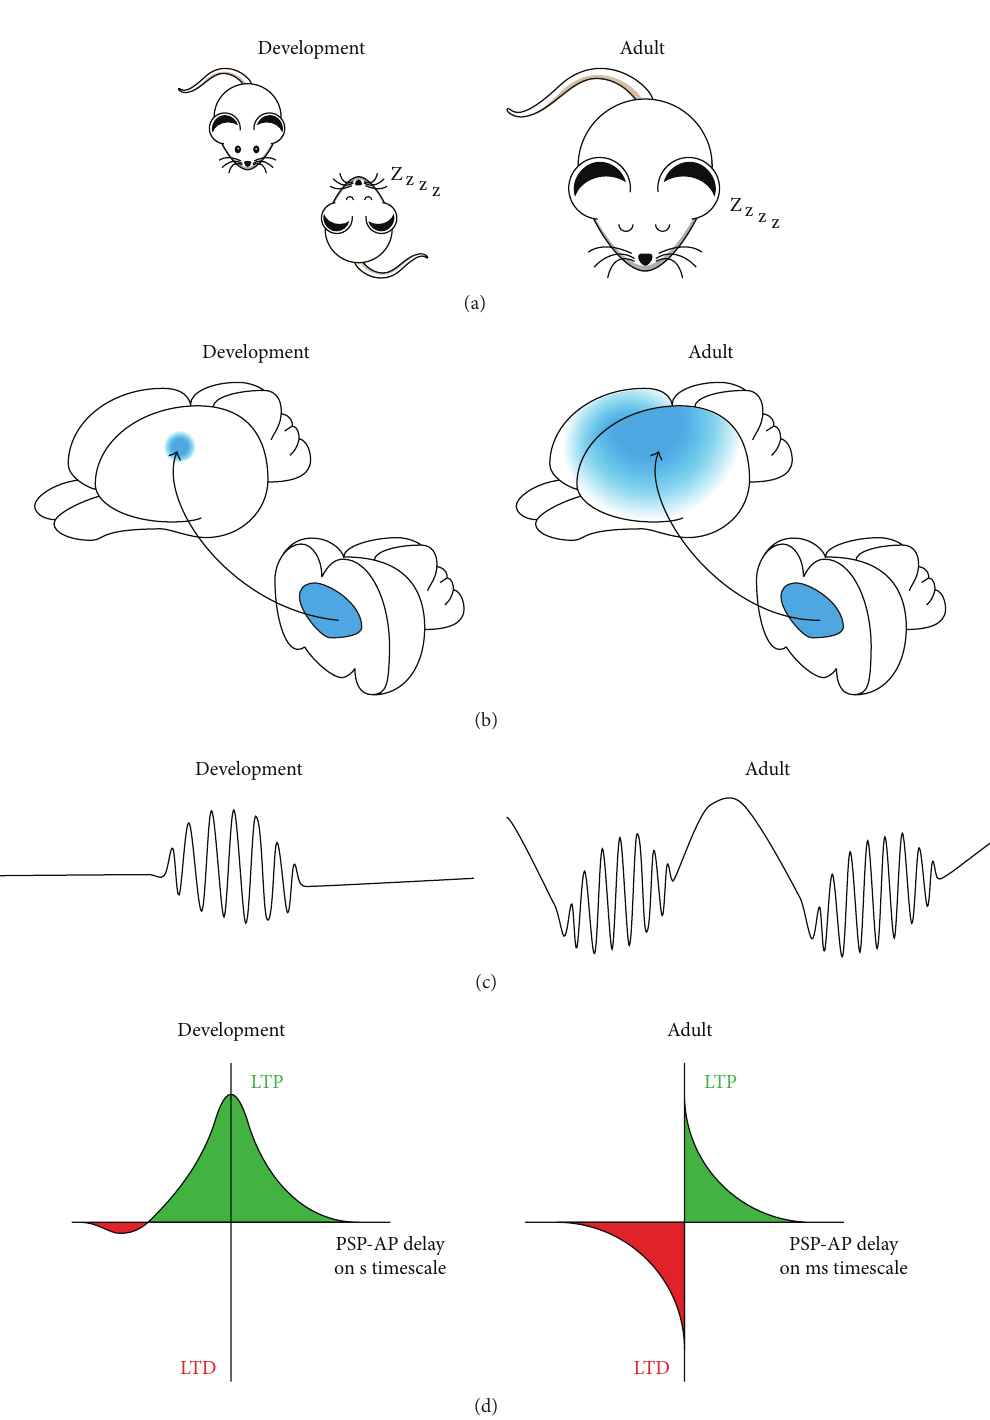
Figure 1: Spindle activity in development and adult sleep. (a) NSBs occur independent of the behavioral state (left), whereas ASSs are confined to SWS (right). (b) Thalamocortical activity locally synchronizes the developing networks (left), whereas ASSs entrain large cortical areas (right). (c) NSBs represent discontinuous patterns of oscillatory activity during early development (left). ASSs are embedded in slow oscillations (right). (d) Synchronized activity during development leads to synaptic potentiation (left). Precise timing of synaptic inputs and action potentials controls synaptic potentiation and depression in mature brains